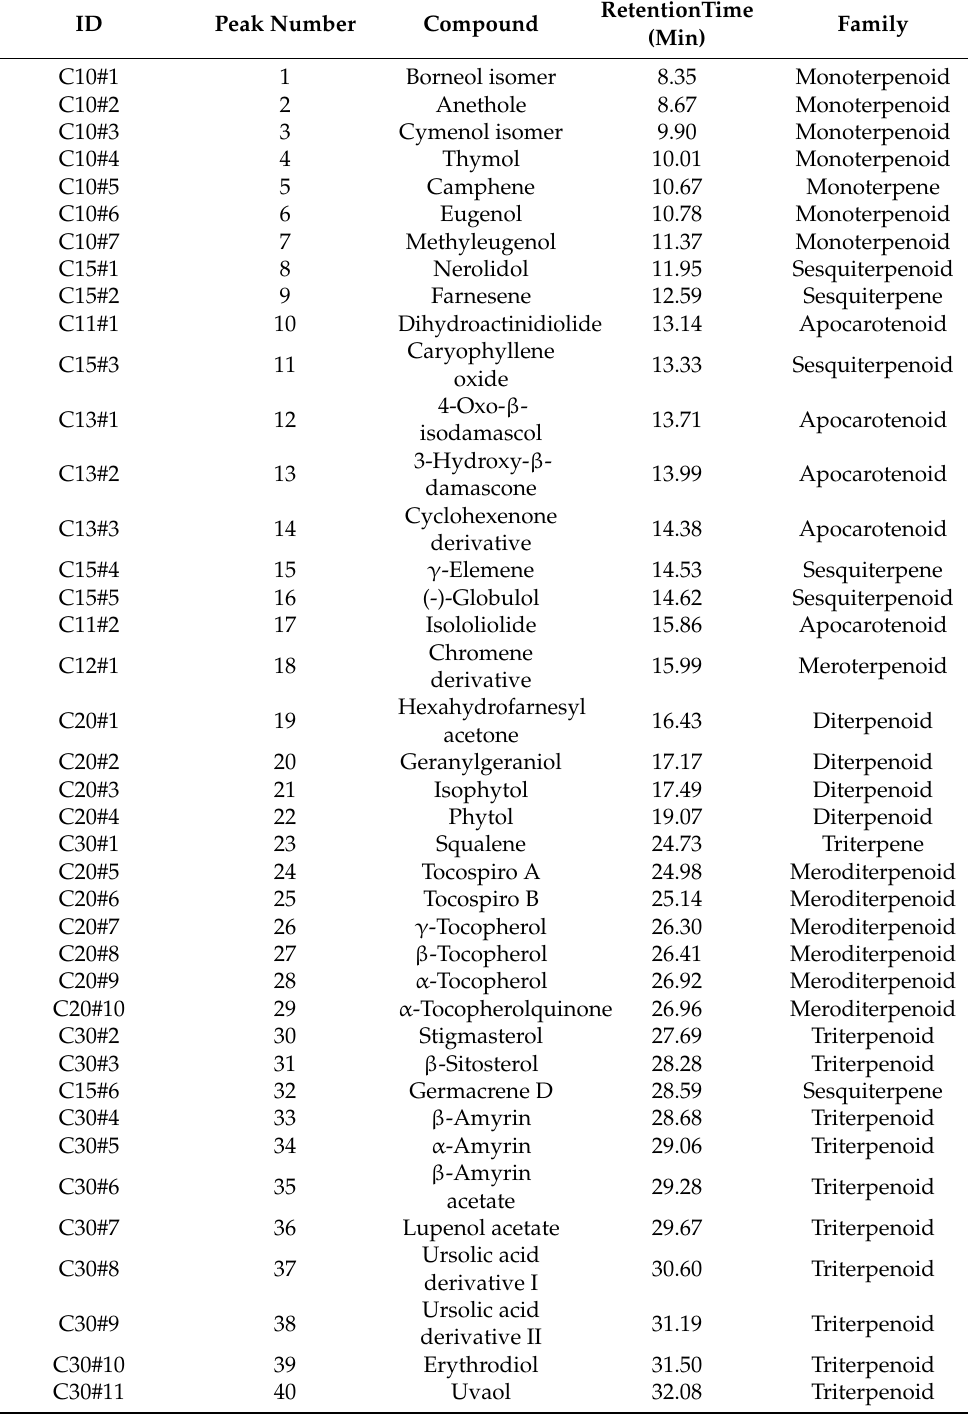
Table 1. Terpenes and terpenoids in olive leaves extracts identified by gas chromatography- quadrupole-time of flight mass spectrometry